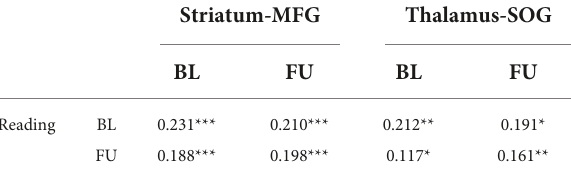
TABLE 3 The correlation matrix between reading and cortico-subcortical functional connectivity at baseline and follow-up assessments